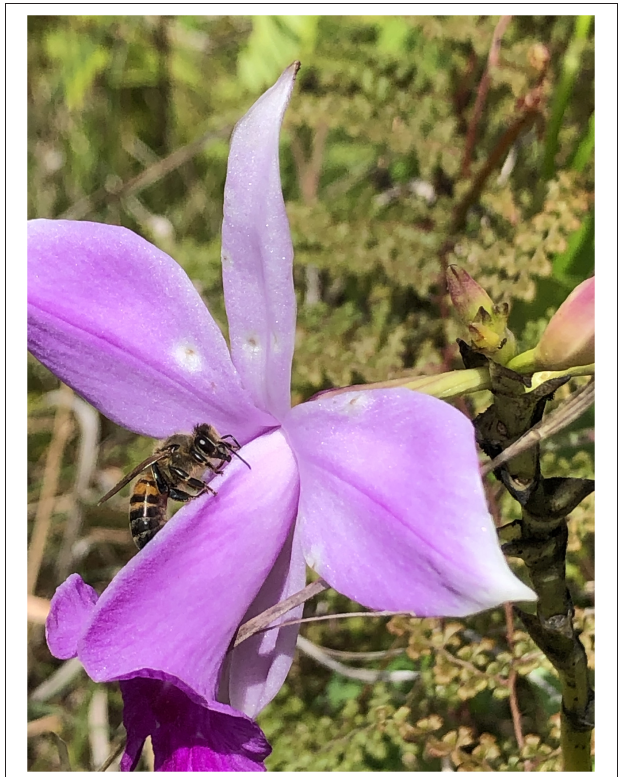
FIGURE 1 | Invasional meltdown in Puerto Rico. Africanized Honey Bees provides pollinator services for the bamboo orchid, Arundina graminifolia , thereby facilitating establishment and spread of the species across the island. Photo: James D.